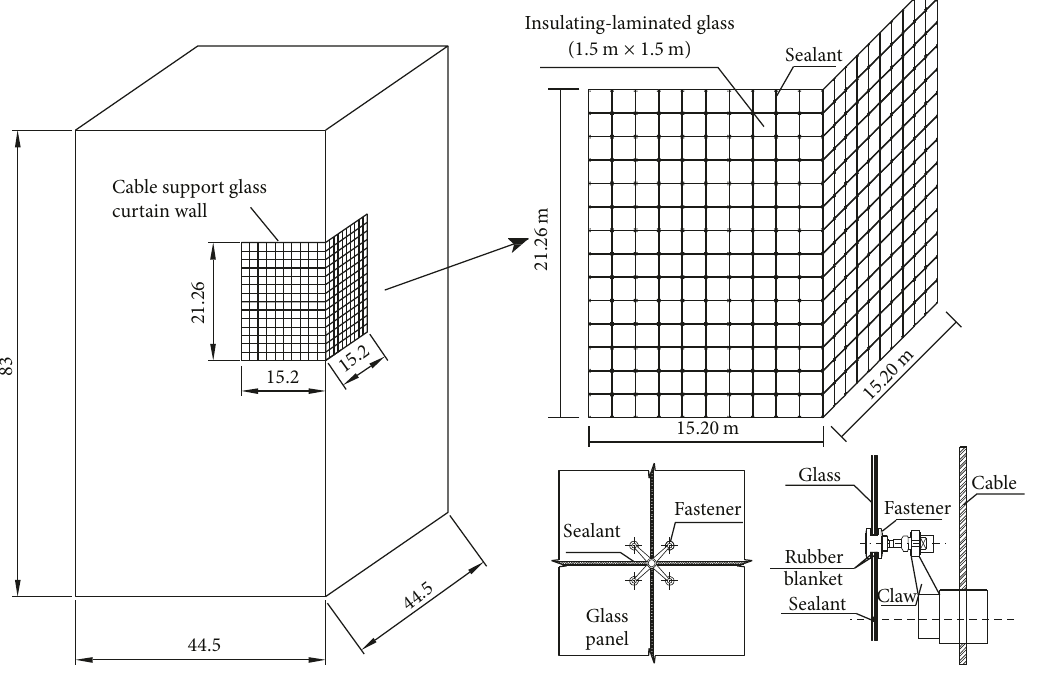
Figure 1: Structural layout